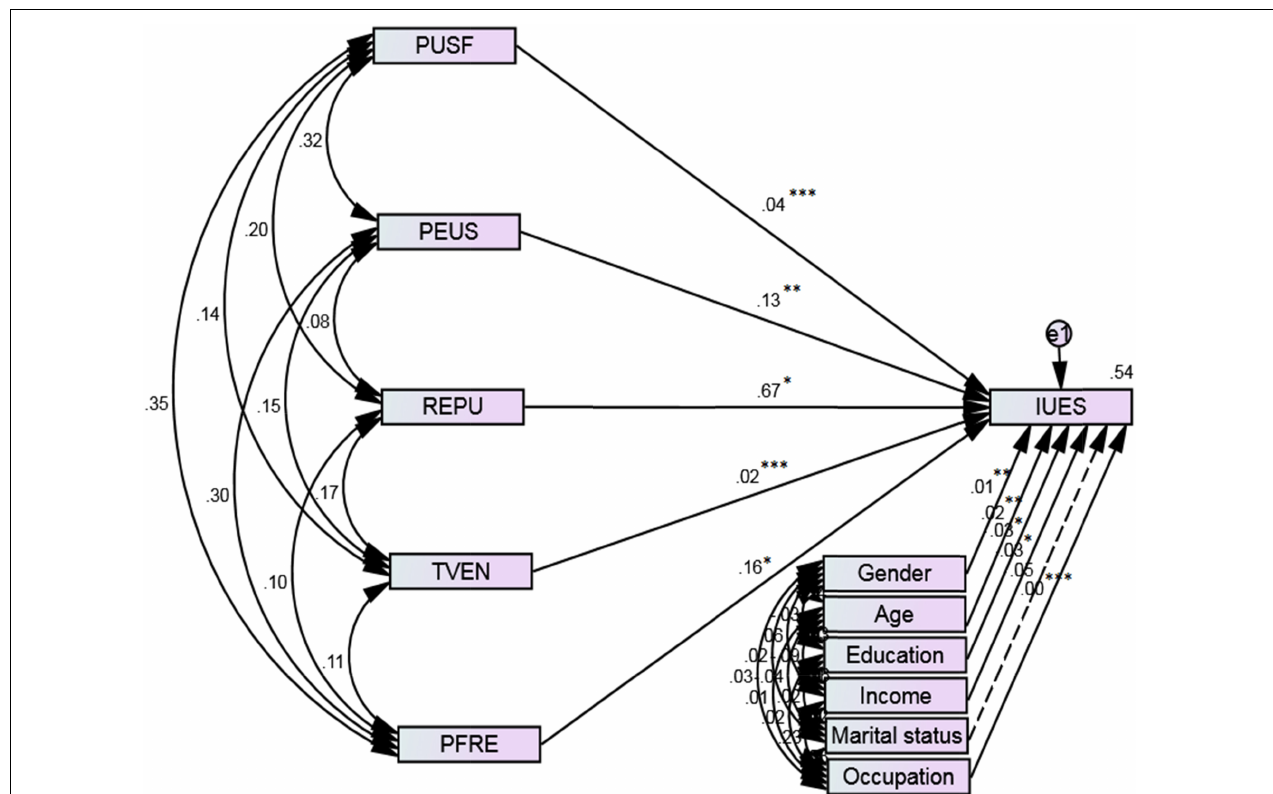
FIGURE 3 | Structural equation modeling path diagram. Insignificant and significant paths are indicated by dashed and continuous lines, respectively. ∗∗∗ p < 0.00, ∗∗ p < 0.01, * p < 0.05. Source: Authors calculation.